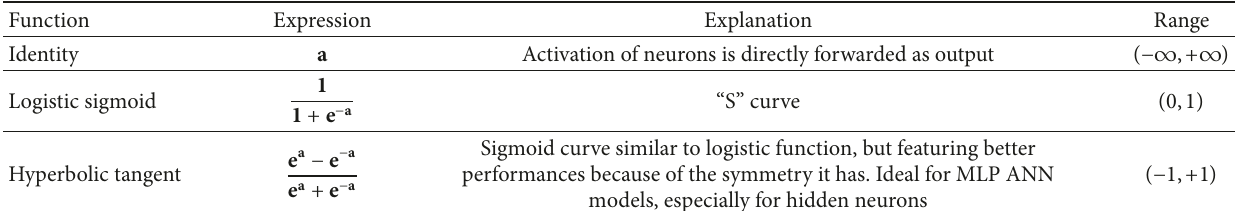
Table 6: Activation functions of MLP ANN models.